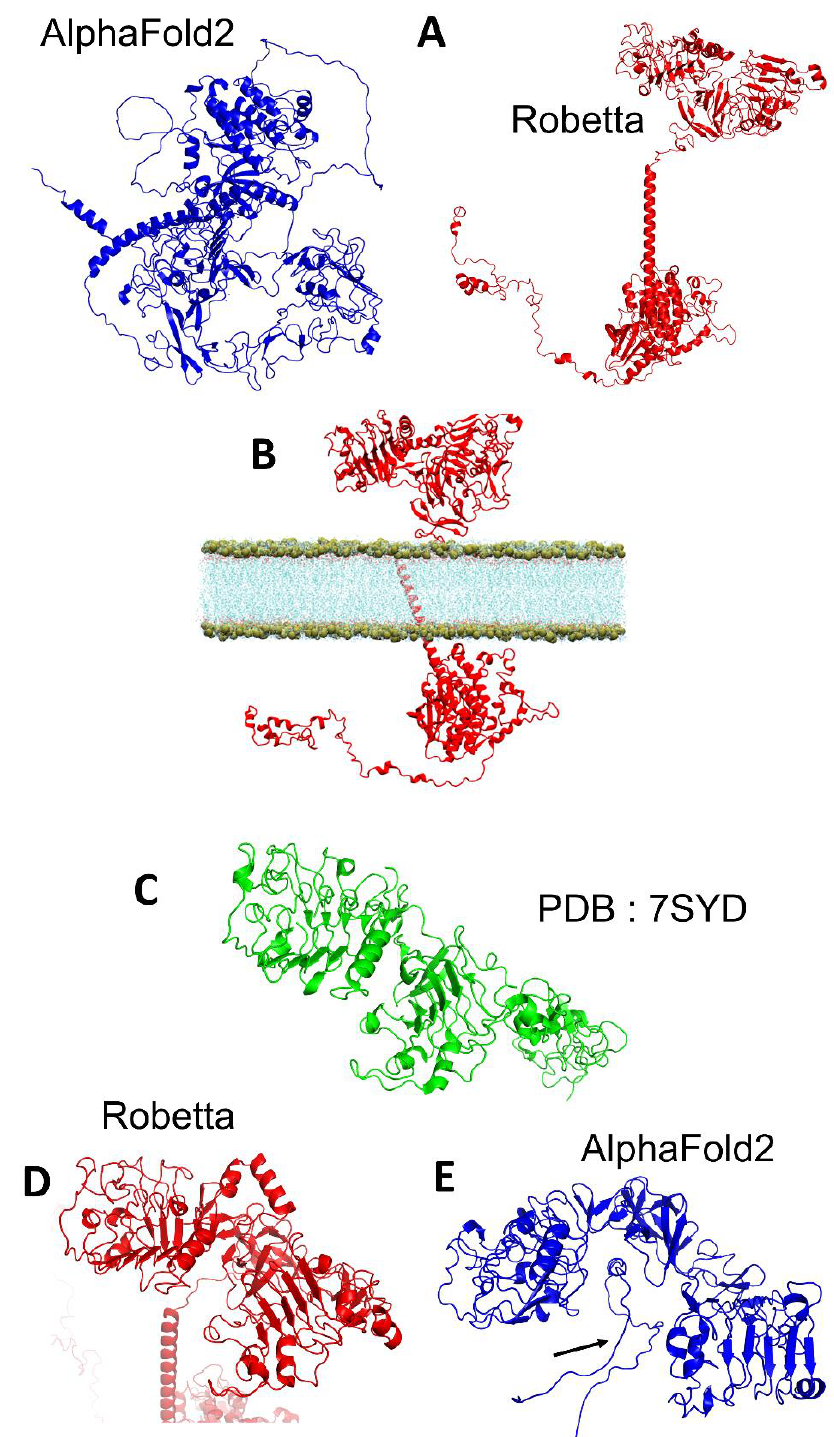
Figure 1. Comparison of the structure of the epidermal growth factor receptor retrieved from Alpha Fold (depicted as cartoon colored in blue) or modelized via Ab-initio calculation on Robetta (red) (A) . Molecular model of the insertion of the receptor obtained by Robetta in a lipid membrane environment ( B ). Comparison of the structure of the epidermal growth factor receptor resolved by Cryo-EM (PDB: 7SYD, resolved from the residue 25 to 638) (( C ), green) with the structure obtained by Robetta (( D ), red) and AlphaFold2 (( E ), blue). In ( E ), the arrow points to an unstructured region that was predicted and inserted by the AlphaFold2 algorithm between the two extra-cellular